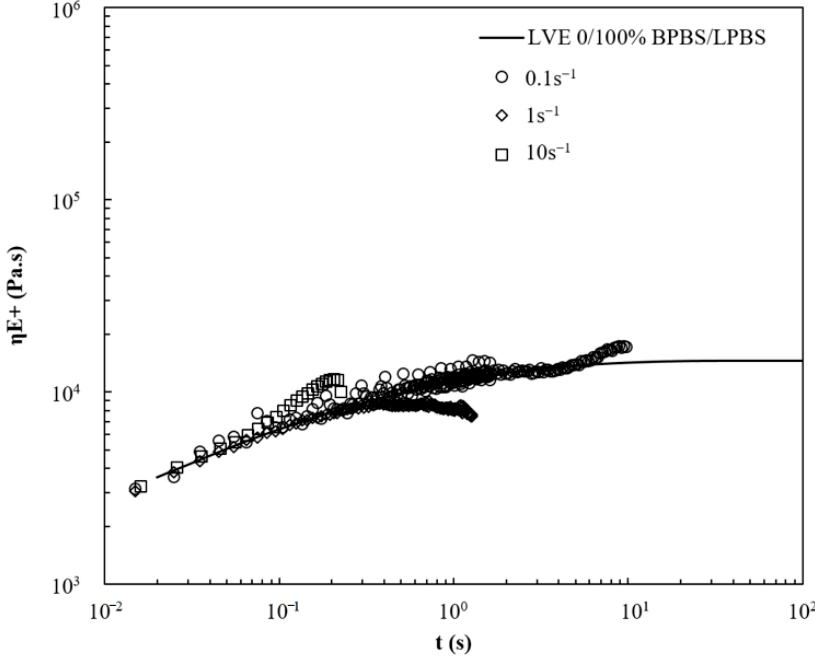
Figure 8. Viscosity curves under extensional flow at various strain rates for LPBS at 150 °C.